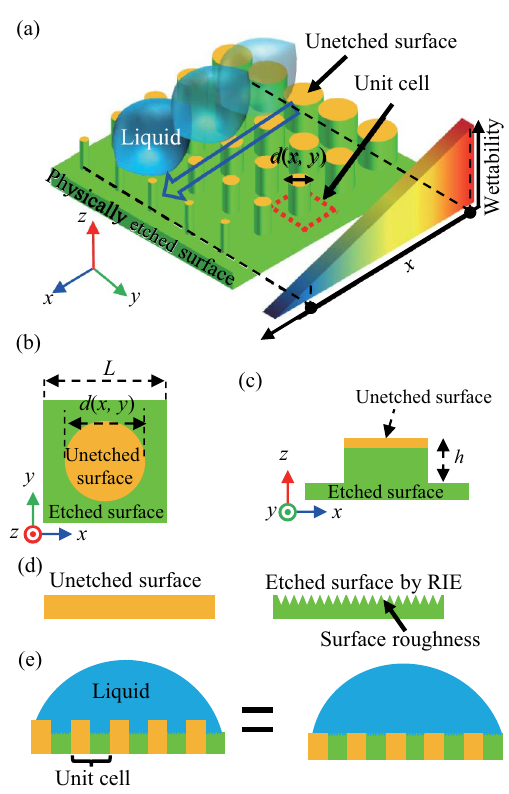
Figure 1. ( a ) Schematic of the surface comprising the wettability designable cells, which provide the 1D wettability gradient. A unit cell (enclosed by the red dotted square) has unetched (yellow) and physically etched x , y (green) regions. The parameter d is the diameter of the pillar. ( b ) Top and ( c ) side view schematics of the unit cells. The side length of the unit cell and height of the pillar are L = 5 µ m and h = 0.2 µ m , respectively, in (cid:30) (cid:31) our fabricated channels. ( d ) Schematics of cross-section for unetched and etched surfaces. ( e ) Schematics of cross-section for the surface paved with the unit cells (left schematic) and equivalent composite surface (right